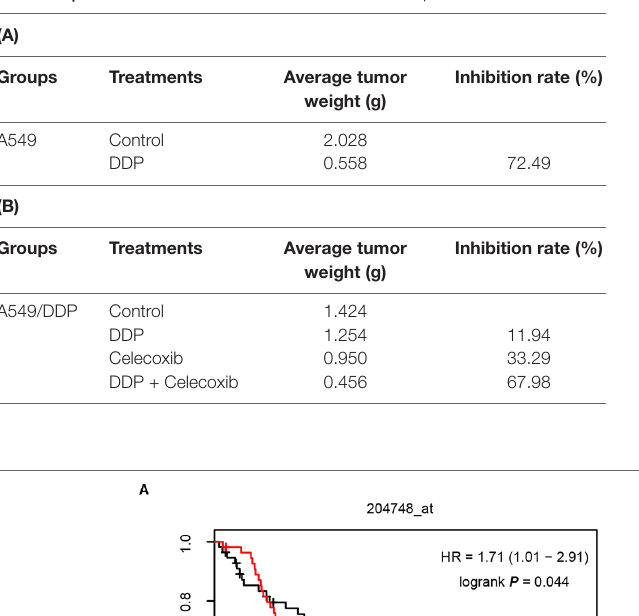
TABLE 2 | PTGS2 inhibitor reversed the resistance to cisplatin in vivo .